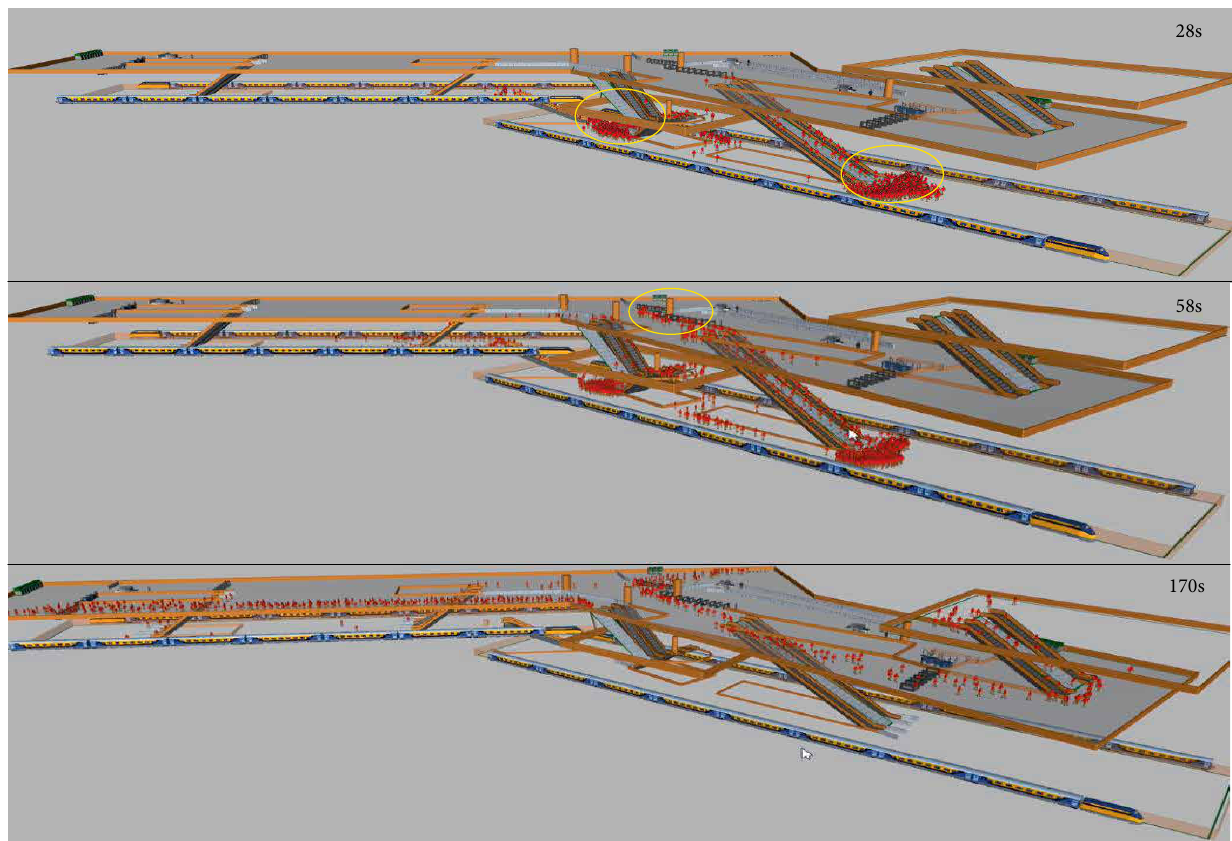
Figure 4: Emergency evacuation at the 28 th , 58 th , and 170 th